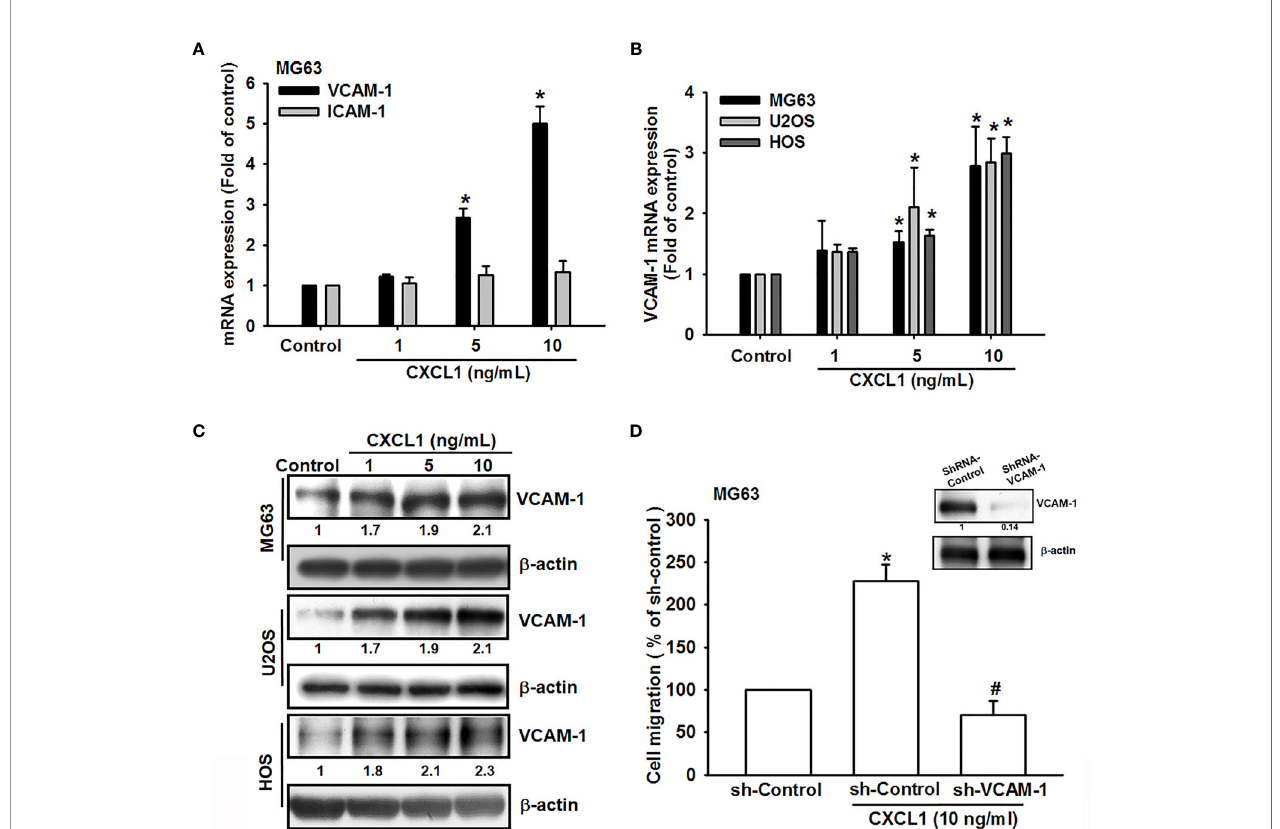
FIGURE 2 | CXCL1 promotes osteosarcoma migration by increasing VCAM-1 expression. (A) MG63 cells were stimulated with CXCL1 (1 – 10 ng/ml) and the mRNA levels of VCAM-1 and ICAM-1 were examined by real-time qPCR. (B, C) CXCL1 increased the VCAM-1 mRNA and protein expression in MG63, U2OS, and HOS human osteosarcoma cells. (D) VCAM-1 expression and migratory potential were examined by immunoblotting and Transwell assays in MG63 cells, which were transfected with VCAM-1 shRNA for 24 h and then stimulated with CXCL1 for another 24 h. The data were collected from at least three individual experiments and expressed as mean ± S.D. * p < 0.05 as compared to the control group; # p < 0.05 compared with the CXCL1-treated shRNA-control